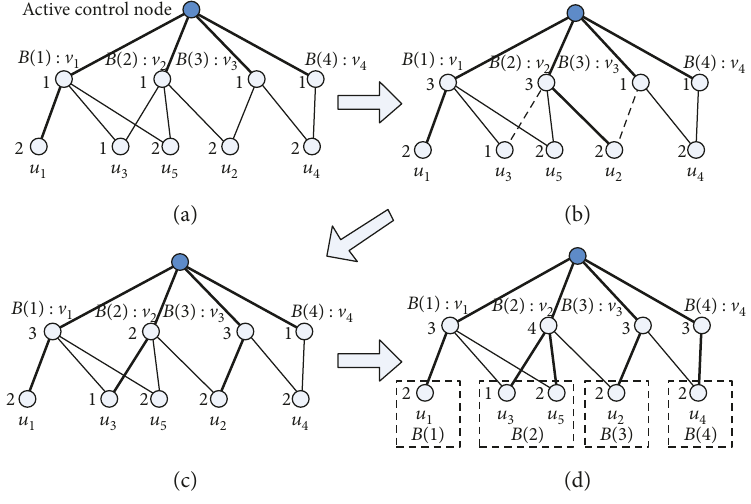
Figure 6: Example for routing tree construction.